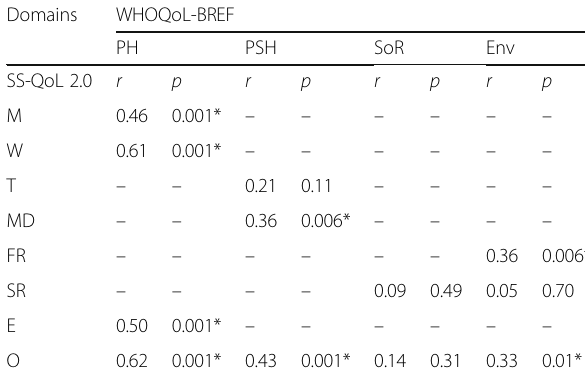
Table 8 Spearman ’ s Correlation of Hausa versions of SS-QoL 2.0 and WHOQoL-BREF